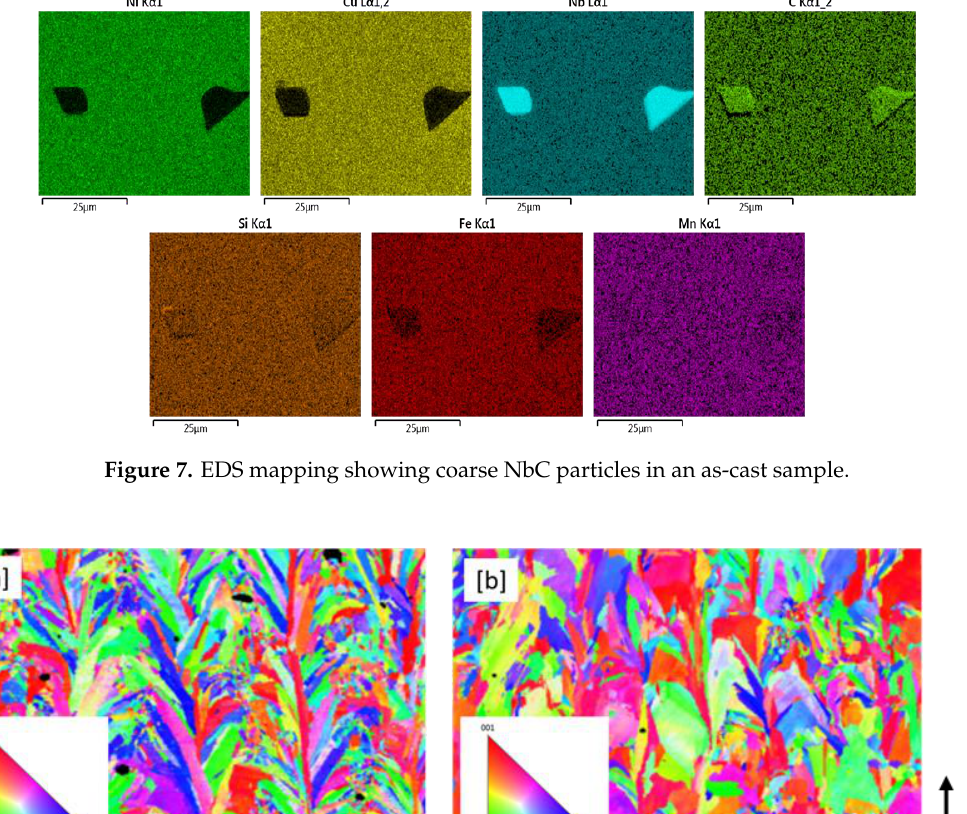
Figure 7. EDS mapping showing coarse NbC particles in an as-cast sample. Figure 6. LOM: ( a ), ( b ) LOM of unetched as-cast samples showing randomly dispersed NbC particles; SEM/energy-dispersive spectroscopy (EDS): ( c ) EDS quantitative measurements of NbC particles in as-cast sample.